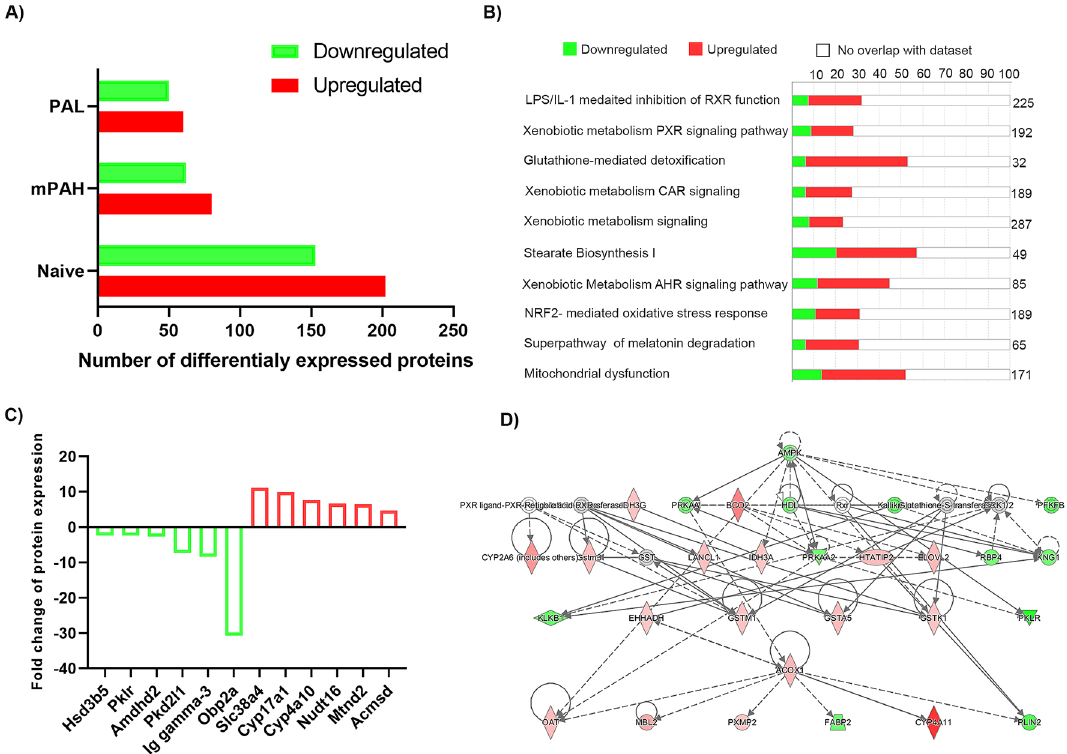
Figure 6. Changes in protein levels in livers of PAH enu2 mice. (A) Number of differentially expressed proteins in naïve, PAH and PAL treated PAH enu2 mice as compared to HET mice. (B) Top 10 pathways affected in the livers of PAH enu2 mice as compared to HET mice analyzed by Ingenuity pathway analysis. Pathways linked to lipid metabolism are the most affected pathways in the liver of PAH enu2 mice. (C) Top 6 upregulated and downregulated proteins in PAH enu2 mice as compared to HET mice. (D) Network analysis identified Lipid metabolism as the top network in the dataset with Cyp4a11 (Cyp4a10 in mouse) at the bottom of the hierarchy. Network analysis figure was generated using Ingenuity Pathway analysis (IPA) (QIAGEN Inc., https:// www. qiage nbioi nform atics. com/ produ cts/ ingen uityp athway- analy